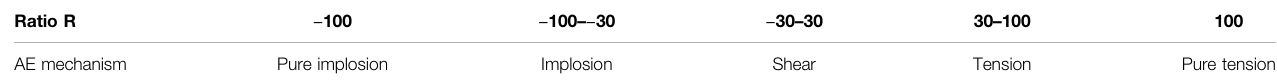
TABLE 3 | The ratio R and corresponding AE source mechanism.